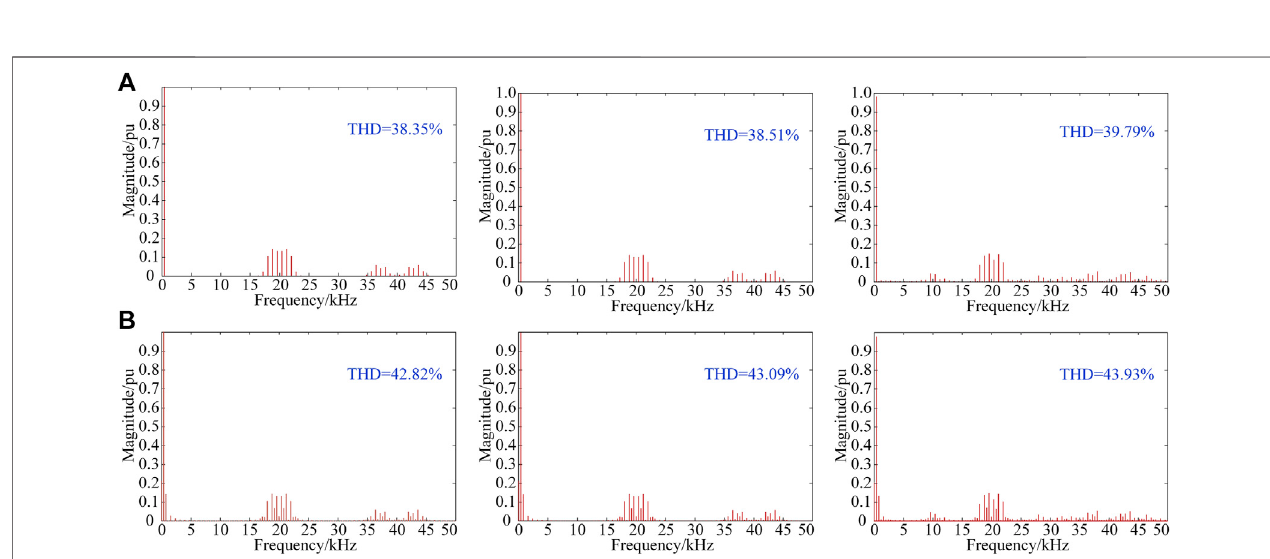
FIGURE10| Experiment resultsofphasevoltageforvarious operationmodesand conditions: (A) parallel, (B) interleaved, (C) unbalanced parallel, (D) unbalanced interleaved.